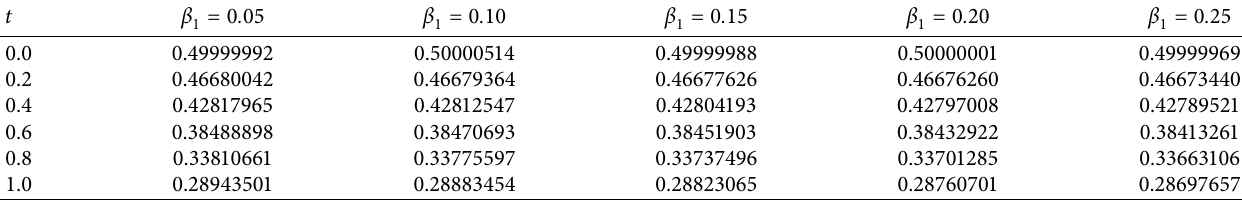
Table 13: Approximate solutions obtained by the LeNN-WOA-NM algorithm for population density of immigrant prey X ( t ) under the . influence of β 1